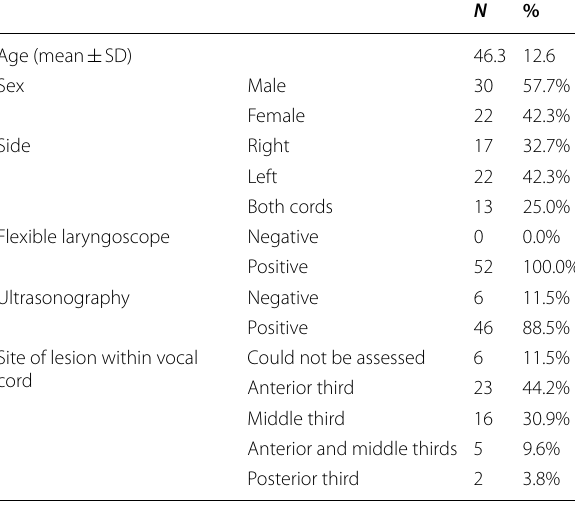
Table 1 The baseline characteristics of the patients included